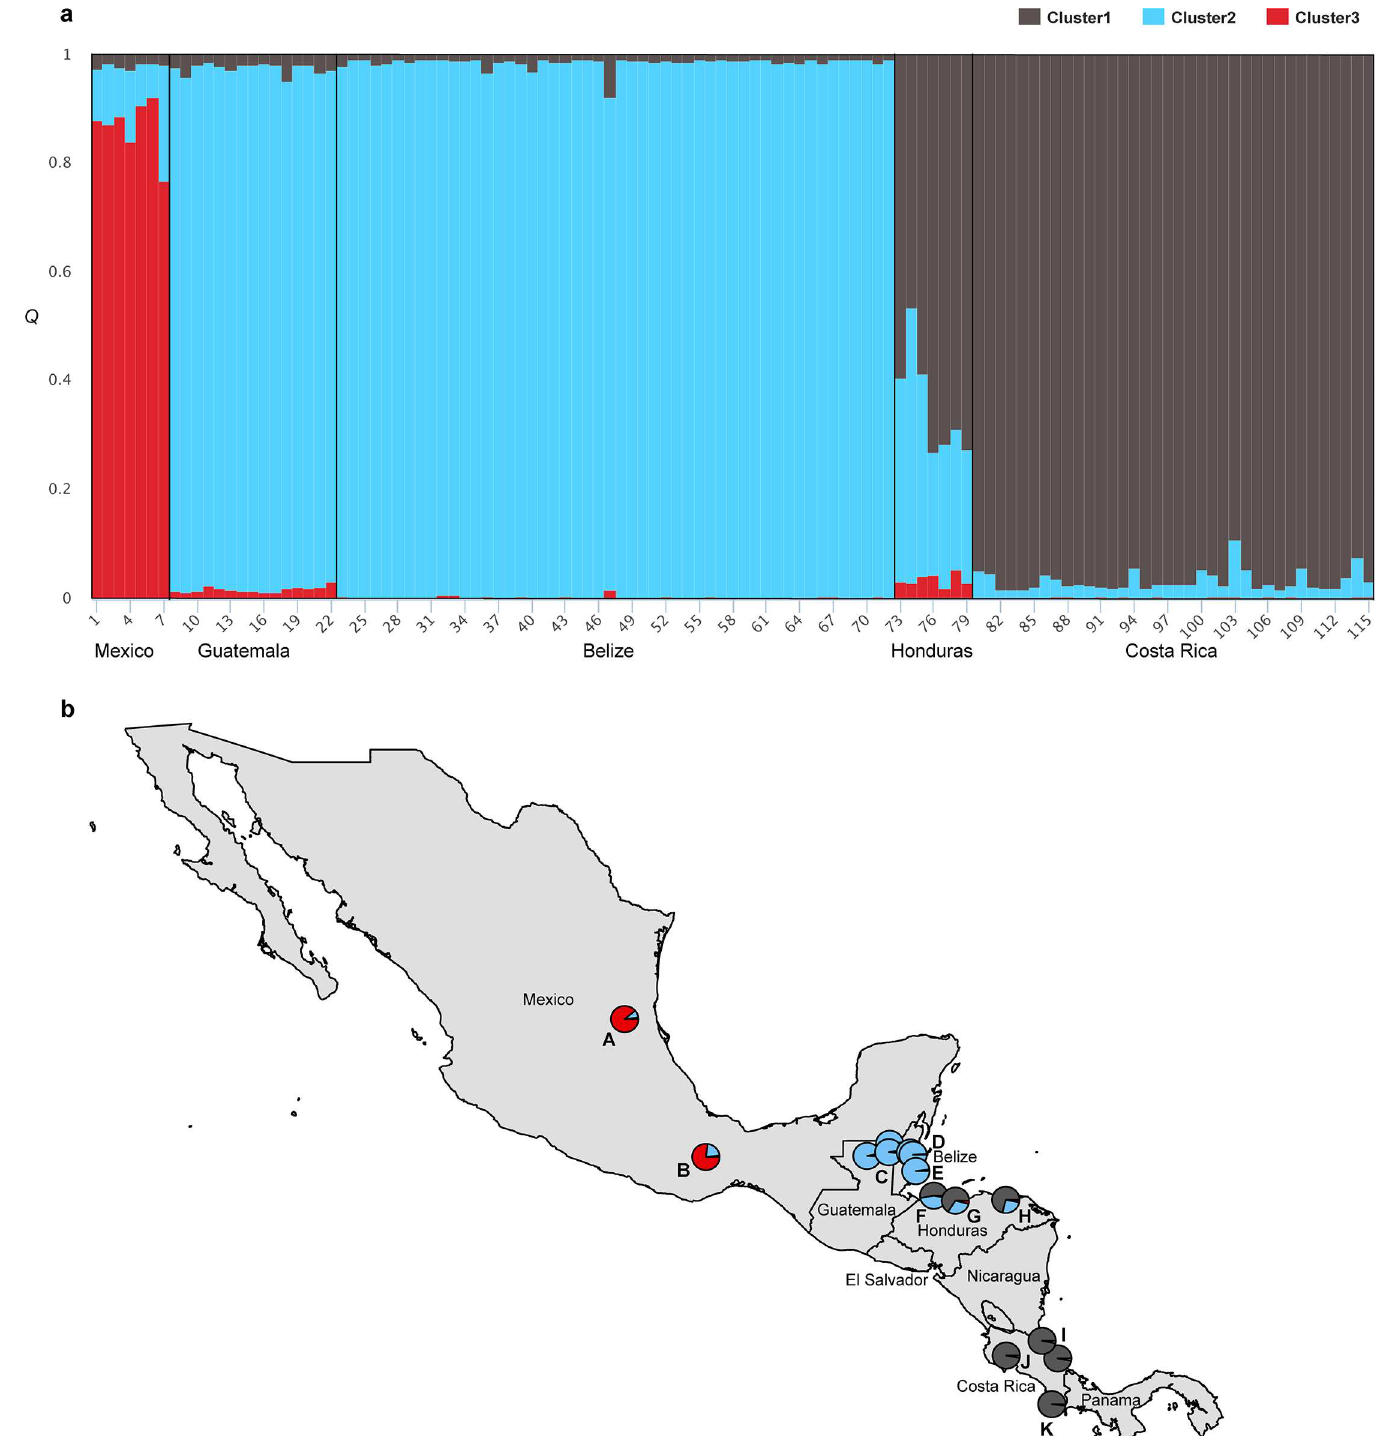
Fig 2. Genetic structure in Mesoamerican jaguars. Results were obtainedfrom Bayesian clustering analysis ( K = 3) using STRUCTURE, version 2.3.4 [47] and genotypedata from 12 microsatellite loci for jaguars ( n = 115) sampled across five Mesoamerican countries (Belize, Costa Rica, Guatemala, Honduras,Mexico). (a) STRUCTURE barplot—vertical bars represent individualsand the color of each bar visualizes the % of membership ( Q ) the individualbelongsto the genetic clusters ( K ) identified.(b) Pie charts represent fractions of Q for groups of jaguar individuals studied across different samplingsites (A, Sierra del Abra TanchipaBiosphere Reserve, Mexico; B, Sierra Mixe, Oaxaca, Mexico; C, northern Guatemala [Laguna del Tigre